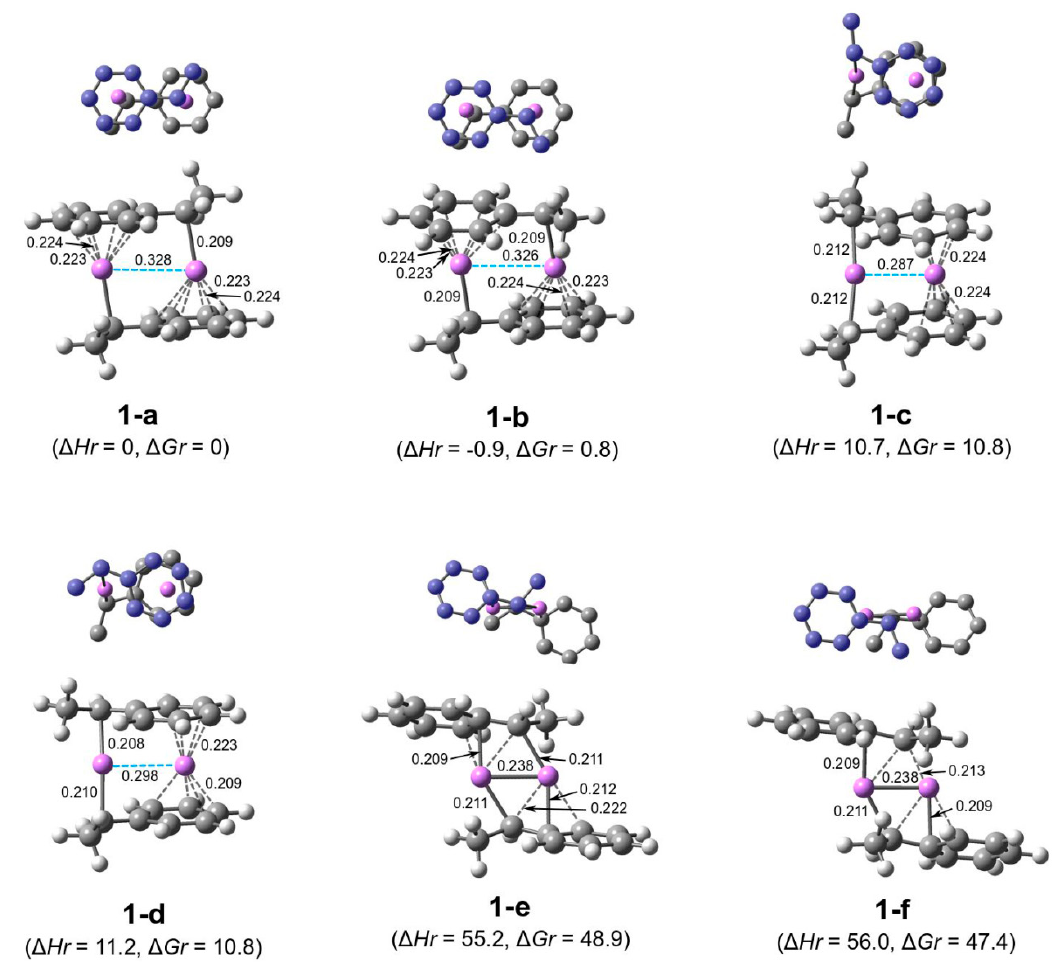
Figure 1. Optimized geometries and relative energies of (HStLi) 2 in the gas phase originally shown in our previous paper. The small drawing on the top of each structure represents simplified overhead view of the lower drawing; carbon atoms in one of the HSt- groups (the upper HSt- group in the lower drawing) are colored in blue. In the lower drawing, C − Li distances less than 0.225 nm are shown. ∆ H r and ∆ G r , which represent the relative enthalpy and free energy, respectively, are expressed in kJ · mol − 1 .